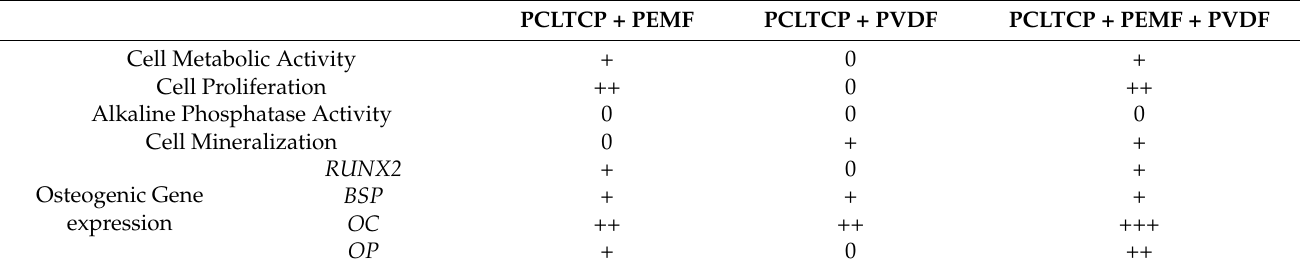
Table 1. Summary of the effect of PEMF and PVDF coating on osteogenesis of MC3T3-E1 cells as compared with the Table legend: 0 = no significant effect; + = greatest effect smaller than twofold enhancement; ++ = greatest effect is between two- to fivefold enhancement; +++ = greatest effect greater than fivefold control group of PCL-TCP scaffolds.